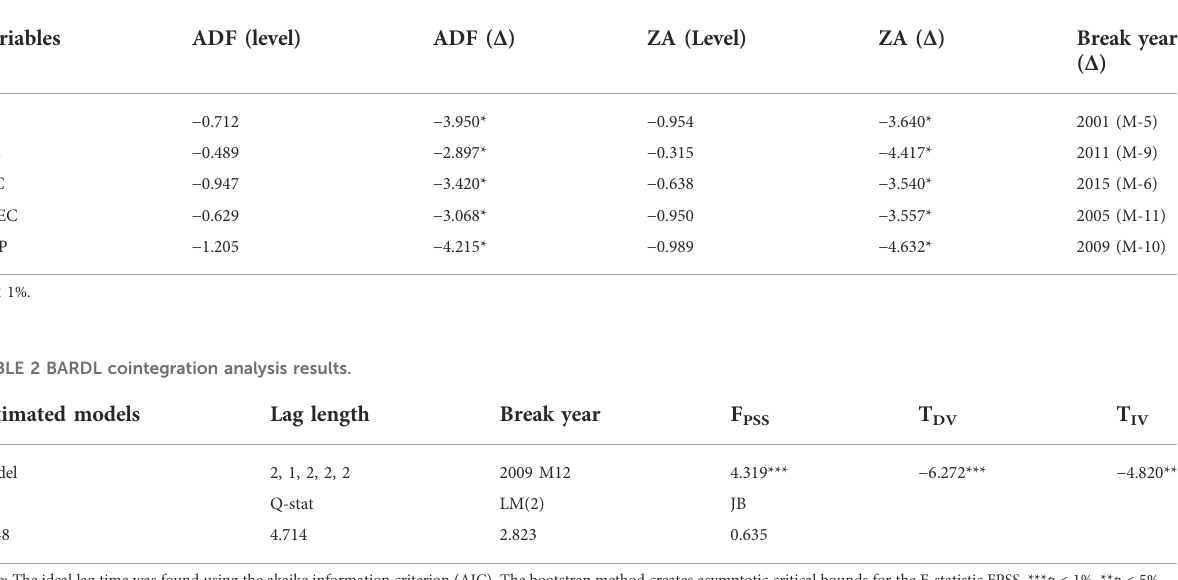
TABLE 1 Results of Unit Root tests.